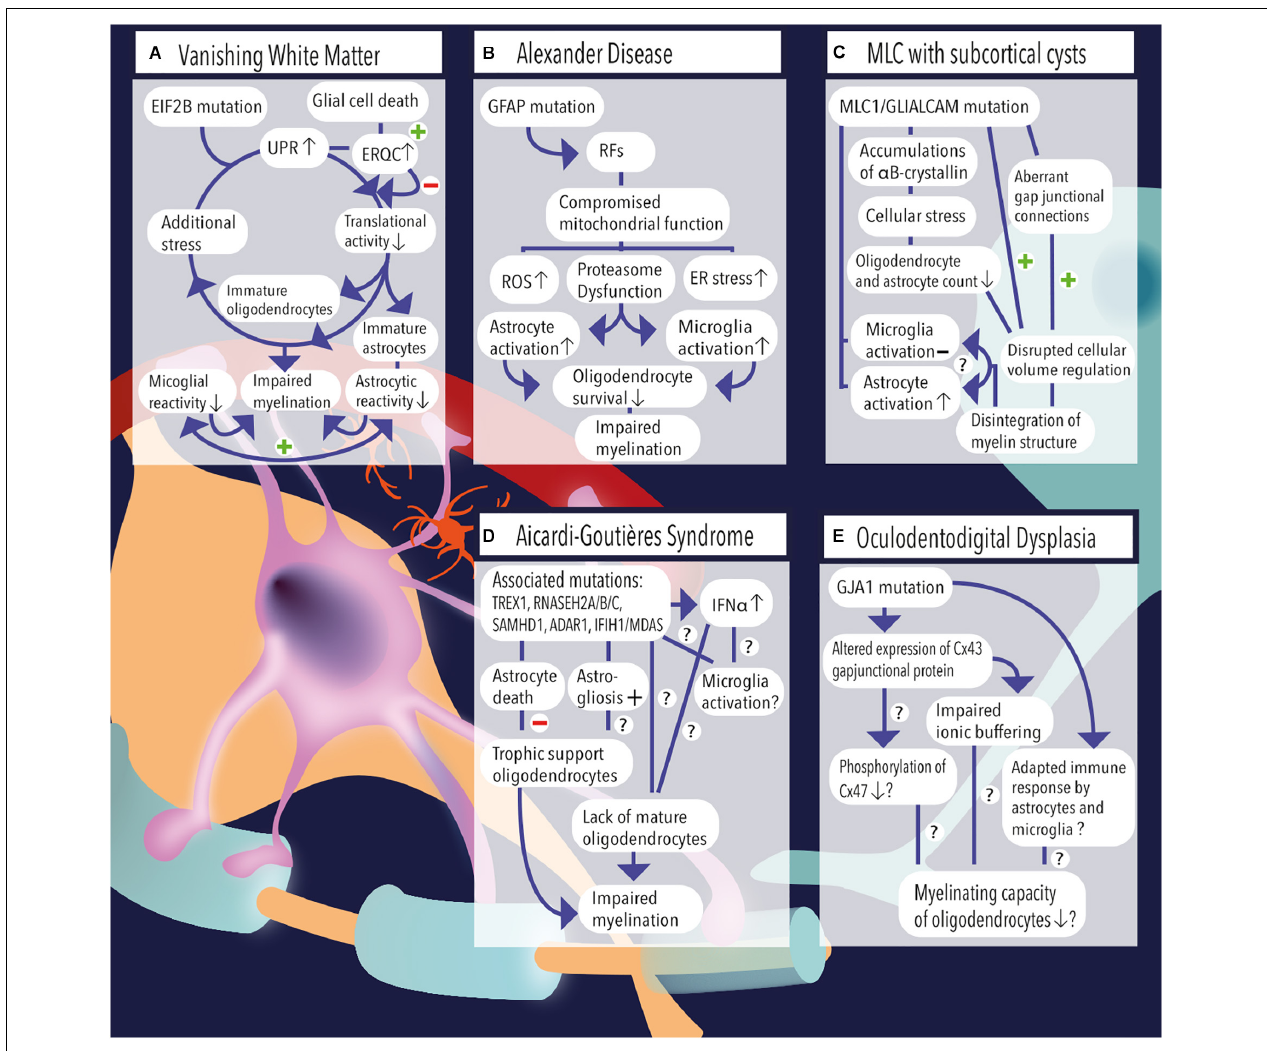
FIGURE 1 | (A) Vanishing white matter is caused by recessive mutations in the EIF2B gene. Induction of the unfolded protein response (UPR) causes lowering of the cellular translational activity and results in glial cell immaturity (e.g., astrocytes and oligodendrocytes). Additional stress (febrile infections or minor head trauma) further induces the cycle of cellular stress. Rescue mechanisms such as endoplasmic reticulum quality control (ERQC) are activated to escape a vicious UPR cycle and promote glial cell death if cellular damage exceeds the threshold for recovery. Vanishing white matter specimens characteristically show reduced astrocytic and microglial reactivity. Together, the lack of mature astrocytes and oligodendrocytes as well as the absence glial cell activation impairs the process of myelination. (B) Overexpression of GFAP due to homozygous mutations in the GFAP gene causes the formation of Rosenthal fibers (RFs) in the cytosol of astrocytes. Astrocytic pathology leads to an impaired respiratory chain complex (i.e., impaired mitochondrial function), which is indicated by increased levels of reactive oxygen species (ROS), endoplasmic reticulum (ER) stress, and proteasome dysfunction as pointed out by activation of kinase pathways. Pathological hallmarks of Alexander disease are prominent activation of astrocytes and microglia. It is hypothesized that sustained activation of both cell types has a detrimental effect on oligodendrocyte survival and contribute to a lack or loss of myelin. (C) MLC1 or GLIALCAM mutations are causally related to the development of megalencephalic leukoencephalopathy (MLC) with subcortical cysts. Accumulations of α B-crystallin have been observed in the cytosol of MLC astrocytes. The resulting cellular stress might relate to the observed reduction in the number (#) of oligodendrocytes and astrocytes. Although microglial activation is absent, MLC specimens demonstrate substantial astrogliosis, which usually are physiologically coupled events. Dysregulation of fluid excesses after neuronal depolarizations (i.e., disrupted cellular volume regulation) results in disintegration of the myelin layers and presence of intramyelinic vacuoles. (D) Aicardi–Goutières syndrome’ associated mutations include TREX1 , RNASEH2A , RNASEH2B , RNASEH2C , SAMHD1 , ADAR1 , and IFIH1/MDAS , which result in an increased and dysregulated production of interferon-alpha (IFN α ), which might be toxic to oligodendrocytes and might induce sustained activation of microglia. Furthermore, AGS mutations have been related to increased astrogliosis and astrocyte death. As oligodendrocytes are highly dependent on trophic support by neighboring astrocytes, their survival rate is severely affected and myelinating capacity is limited. Yet, it is unclear whether Aicardi–Goutières-associated mutations might (also) have an effect on microglial activation or oligodendrocyte maturation directly. (E) A mutation in the GJA1 gene, which is associated with oculodentodigital dysplasia, causes altered expression of the gap junctional hemichannel Cx43, which is abundantly expressed in astrocyte–astrocyte and astrocyte–oligodendrocyte contacts. A direct consequence of altered Cx43 expression might be a phosphorylation defect of Cx47 on the oligodendrocyte’ membrane, which in turn negatively affects their myelinating capacity. In addition, impaired ionic buffering of K + and Na + ions might affect oligodendrocyte homeostasis and affect the process of myelination. In addition, adaptations in the immunological response of astrocytes and microglia have been observed and related to altered expression of Cx43.